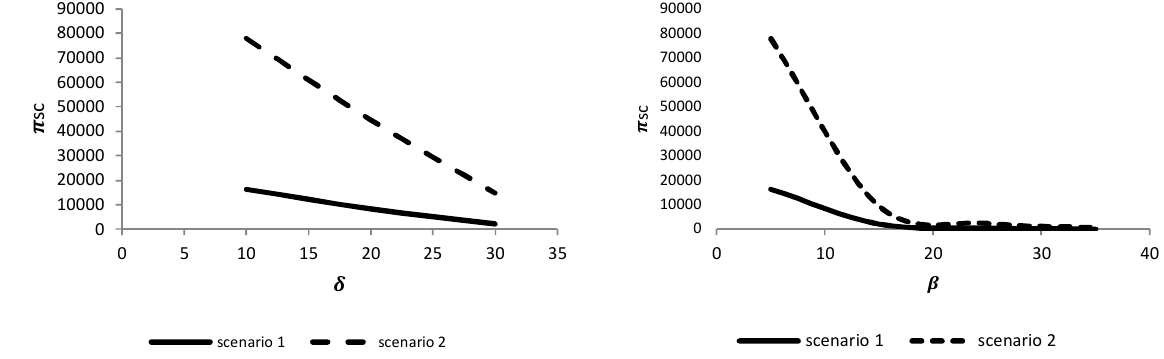
Fig 3. The retailer's expected profit function in terms of " β " and " δ "